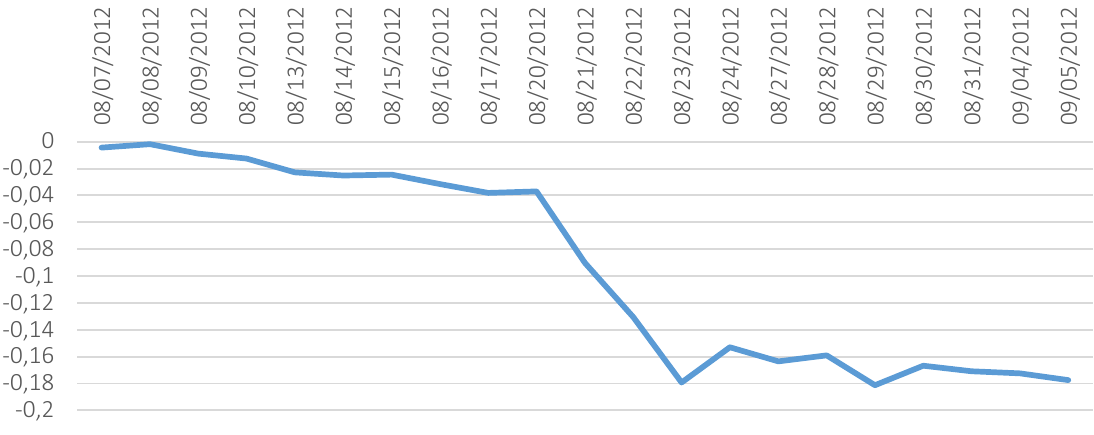
Figure 3. STB’s CAR [–10;10] for the first event in 2012